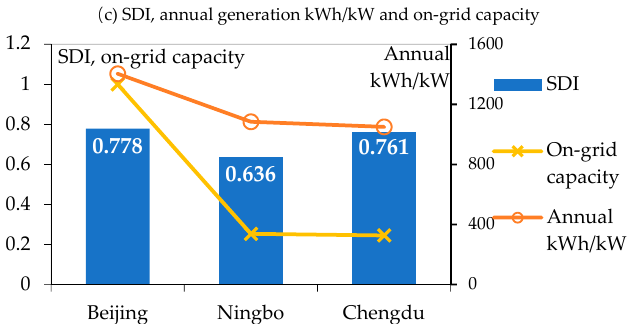
Figure 8. Comparison of sustainability evaluation of three city ADNs. ( a ) Comparison of the weighted indicators; ( b ) weights of the indicators; ( c ) annual generation of per kW DGPVs.